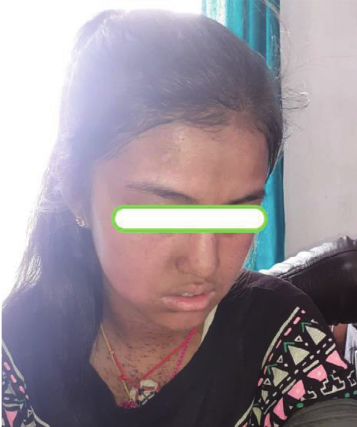
Figure 2: Patient during discharge from the health center at 2 weeks.